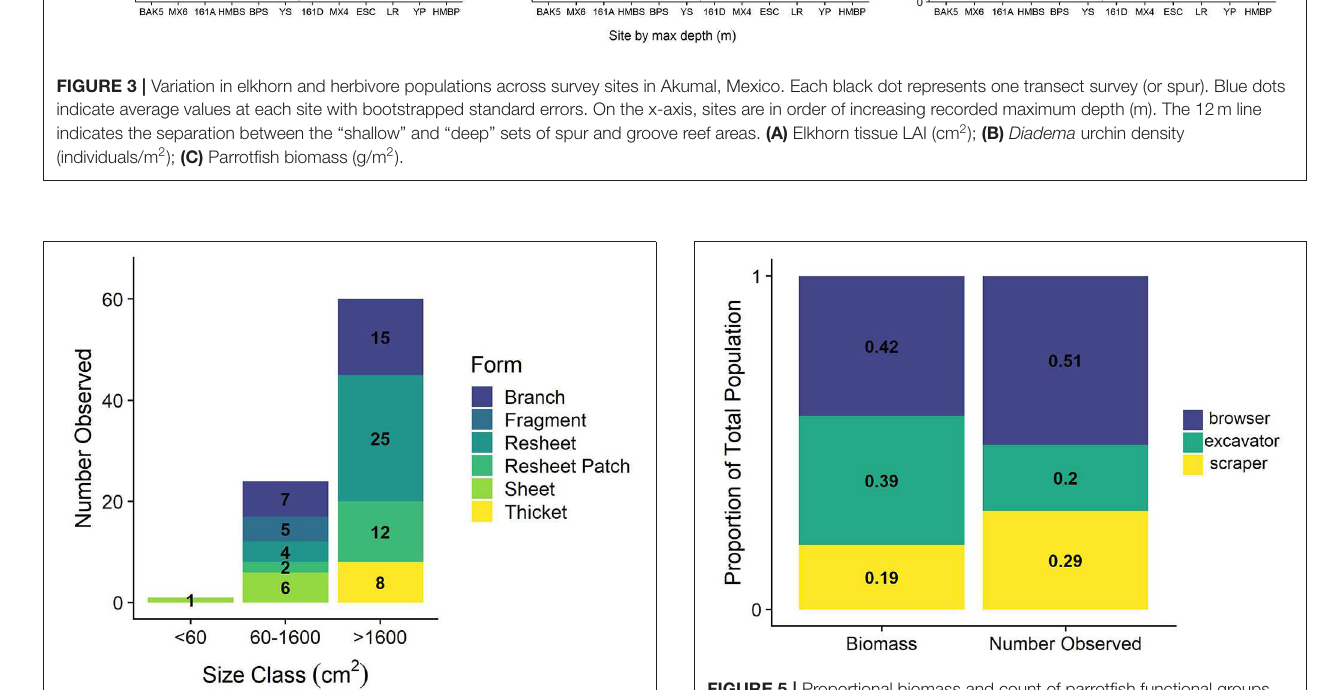
FIGURE 5 | Proportional biomass and count of parrotfish functional groups. Species were classified as browser, scraper, or excavator based on previous analysis from Adam et al.